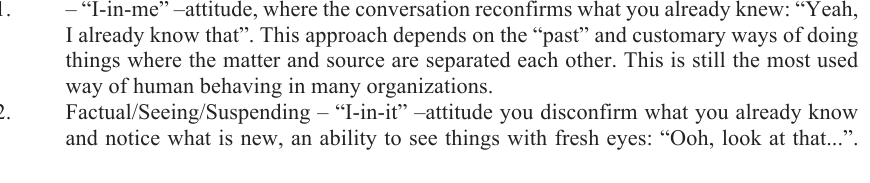
Table 1. The new levels of listening by Otto Scharmer (2009, p.